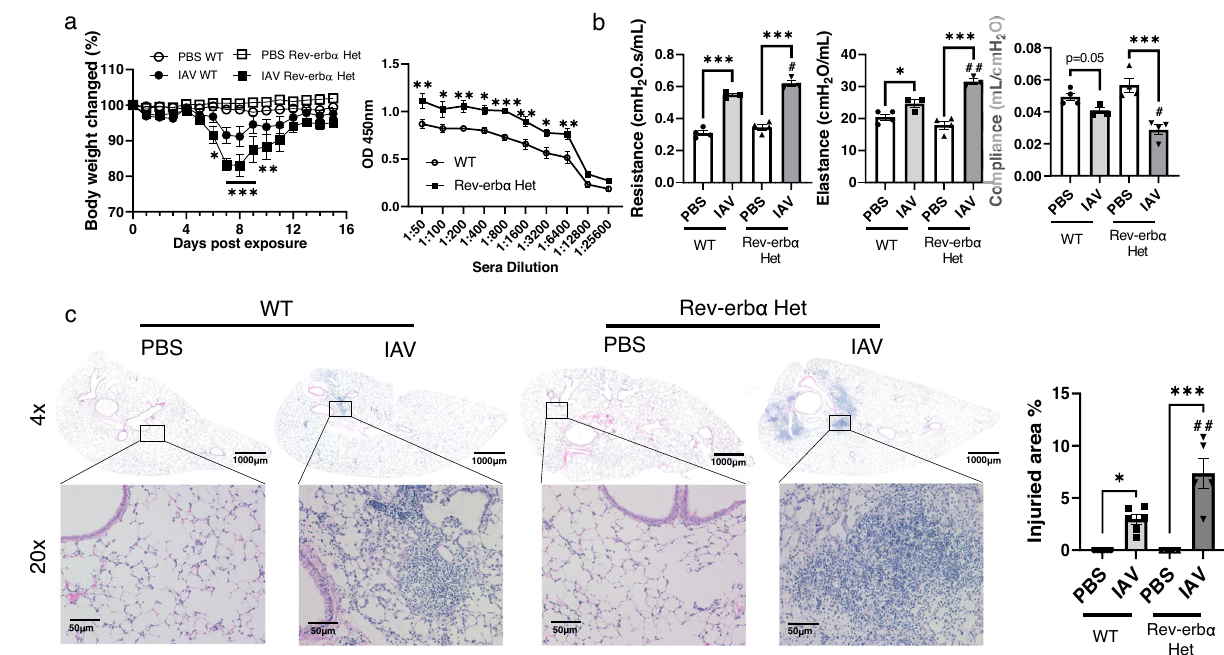
Fig. 5 | IAV inducedlung injury and pro fi brotic responses exaggerated in Rev- erb α Het mice compared to WT mice. WT and Rev-erb α Het mice were infected (10 3 PFU/mouse) with IAV or PBS control for 15 days. a Body weights were mon- itored during infection, and virus-speci fi c antibodies in serum were detected by ELISA( n =5 – 19micepergroup,* p <0.05,** p <0.01,*** p <0.01vs.IAVinfectedWT mice). b During sacri fi ce, lung mechanics (resistance, compliance, and elastance) weremeasured.( n =3 – 4micepergroup). c H&Estainedlungsectionswereusedto analyzetheinjuredareainducedbyIAVinfection.Regionswithintheblacksquares were shown with ×20 magni fi cation ( n =4 – 6 mice per group).Data were shown